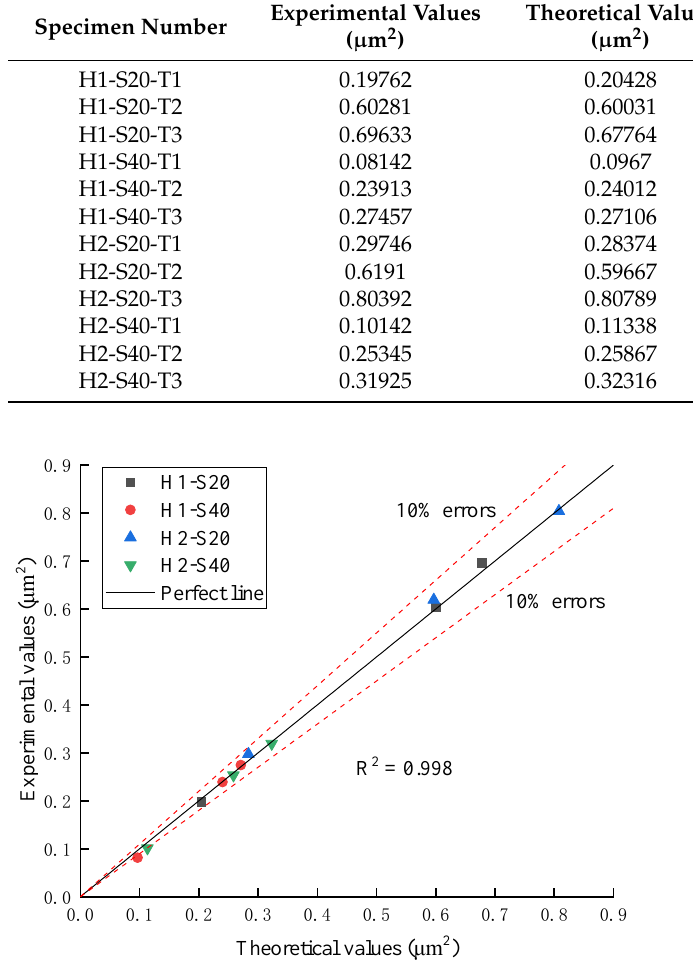
Figure 18. Comparison between the experimental and theoretical values.